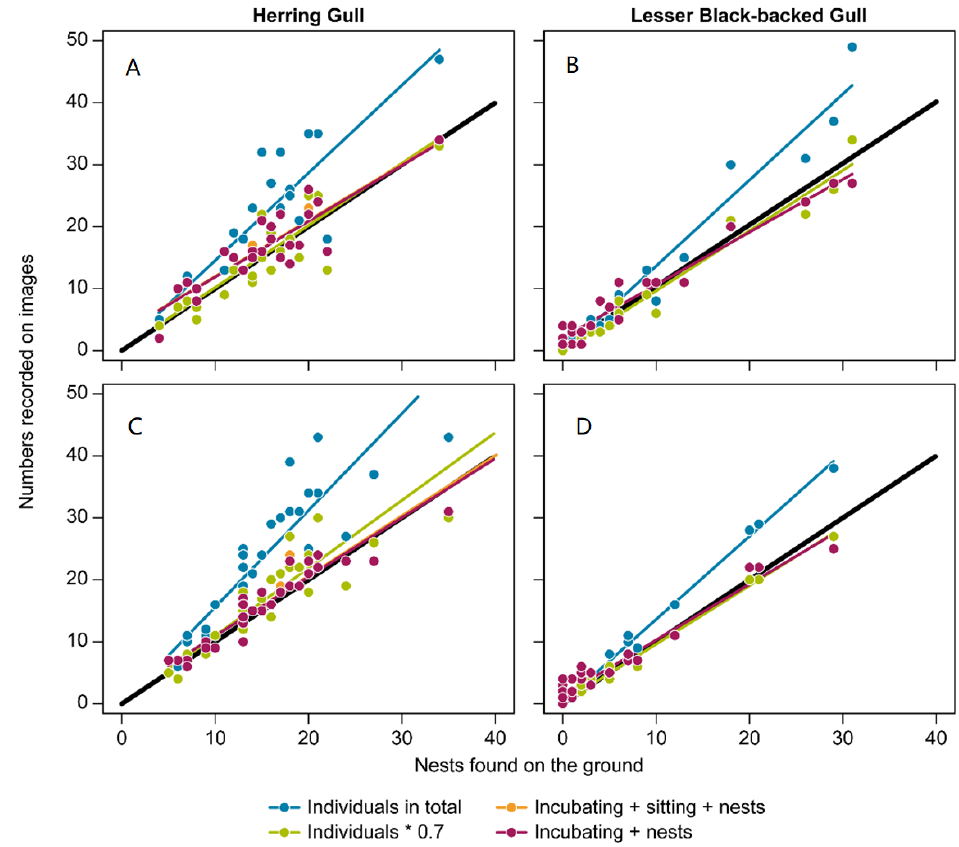
Figure 3. Linear models showing the relation between the number of nests found inside the circle plots and the number of gulls counted on photos taken from the drone on 14 and 15 May ( A , B ) and 29 and 30 May ( C , D ). Values for the Herring Gull (HG) are represented in graphs ( A ) and ( C ), whereas values for the Lesser Black-backed Gull (LBBG) are represented in graphs ( B ) and ( D ). The mean number of individuals present inside the two plots photographed Table 2. Mean number of individuals of HG and LBBG present in two sections of the colony within 2 h periods from 04:20 to 06:00 h. ‘N’ is the number of 20 min intervals where a photo was taken during the 2 (HG) or 3 (LBBG) days of survey.